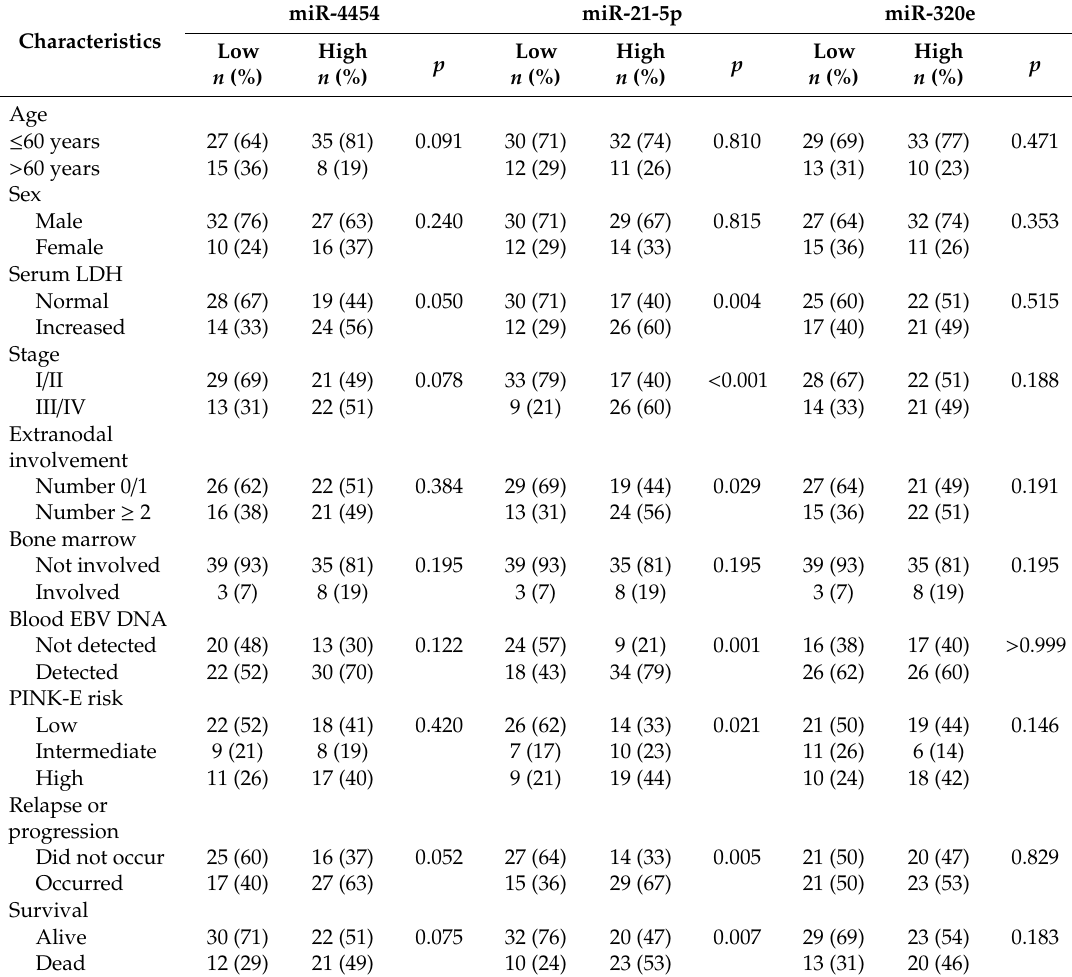
Table 2. Association of exosomal miRNAs with the characteristics of the validation cohort.